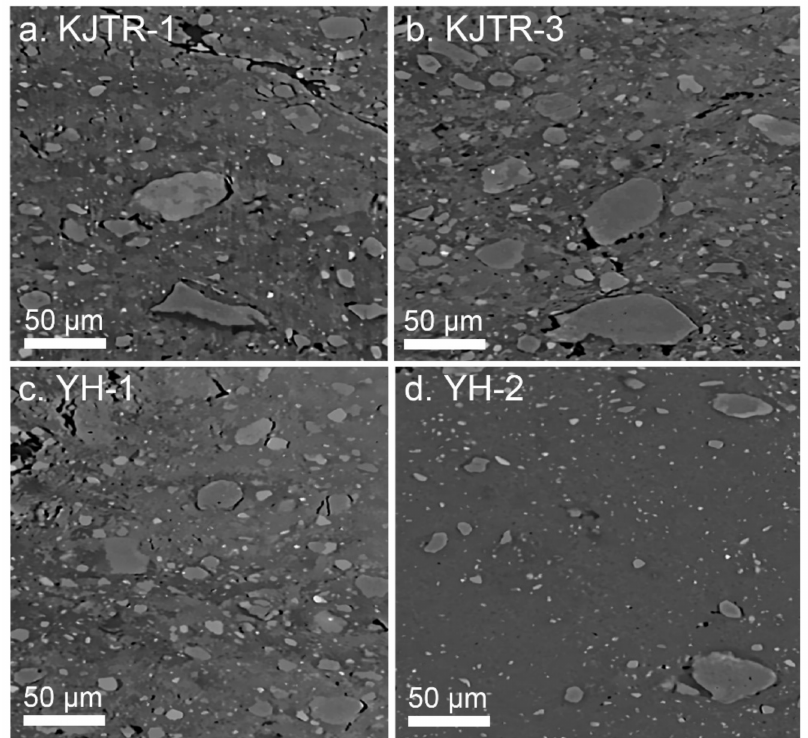
Figure 5. 2D images of a cross-section taken from the CT images (Figure 4) of each sample. ( a ) KJTR-1; ( b ) KJTR-3; ( c ) YH-1; ( d )